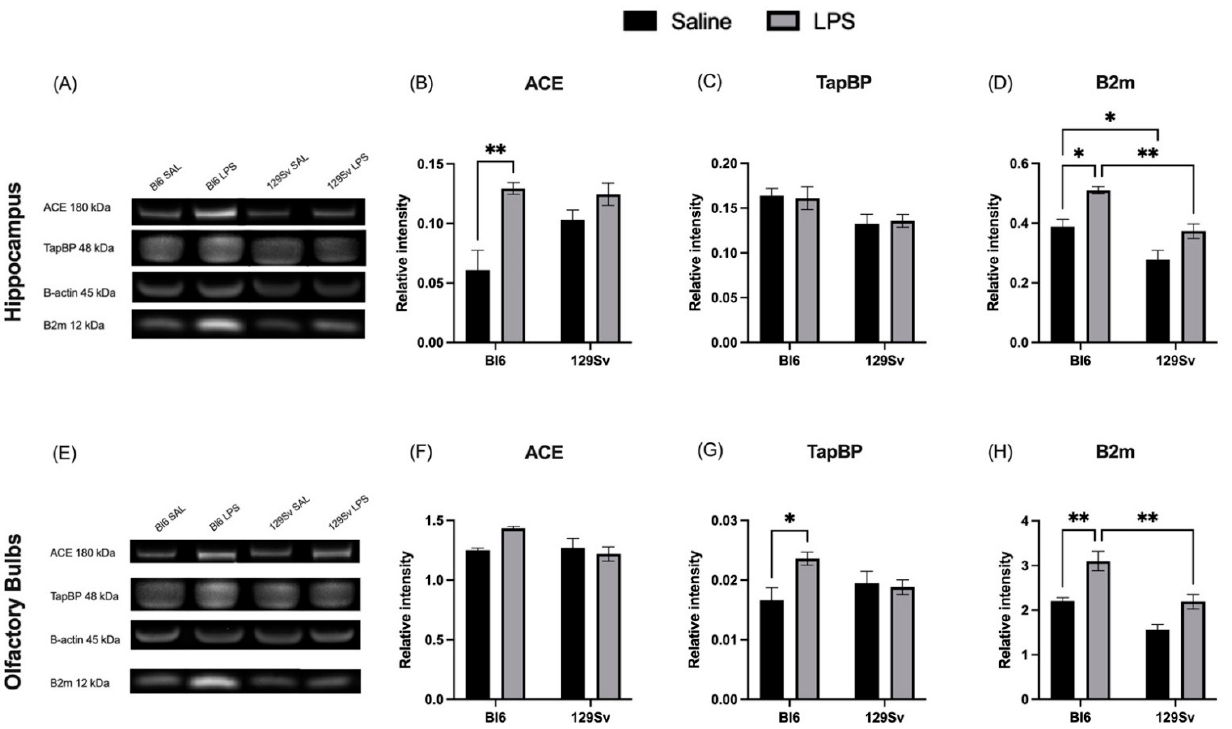
Figure 7. Representative immunoblots ( A ) and protein expression analysis of ACE ( B ), Tapbp ( C ), and β 2m ( D ) in hippocampus. Representative immunoblots ( E ) and protein expression analysis of ACE ( F ), Tapbp ( G ), and β 2m ( H ) in olfactory bulbs. Data were analyzed by two-way ANOVA with Bonferroni post hoc test and presented as mean ± SEM ( n = 3–6): * p ≤ 0.05, ** p ≤ 0.01.